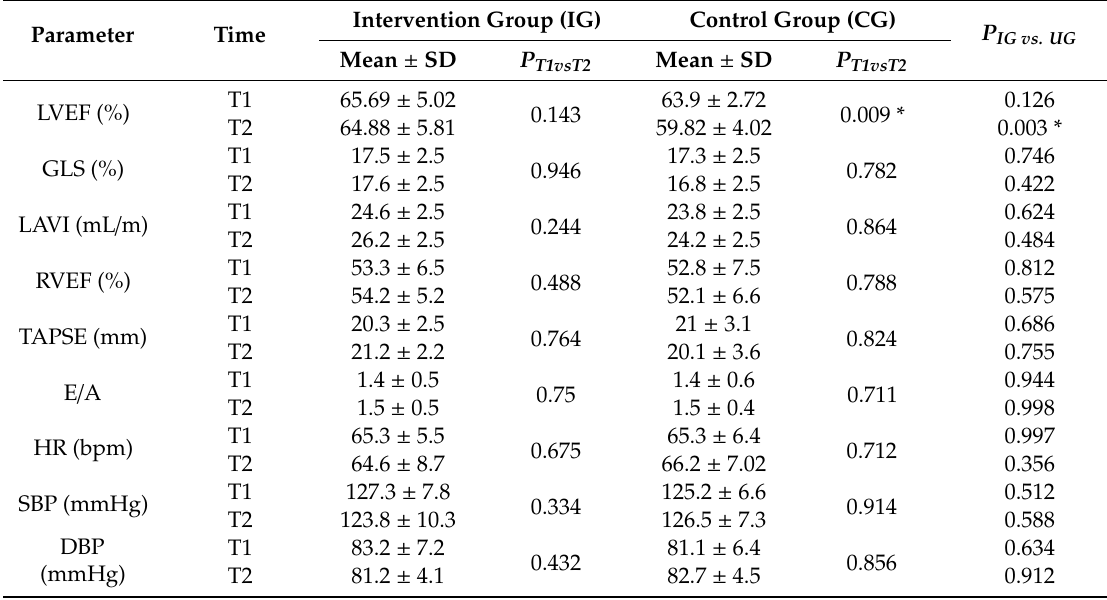
Table 2. Comparison of the cardiac function assessment in both study groups.